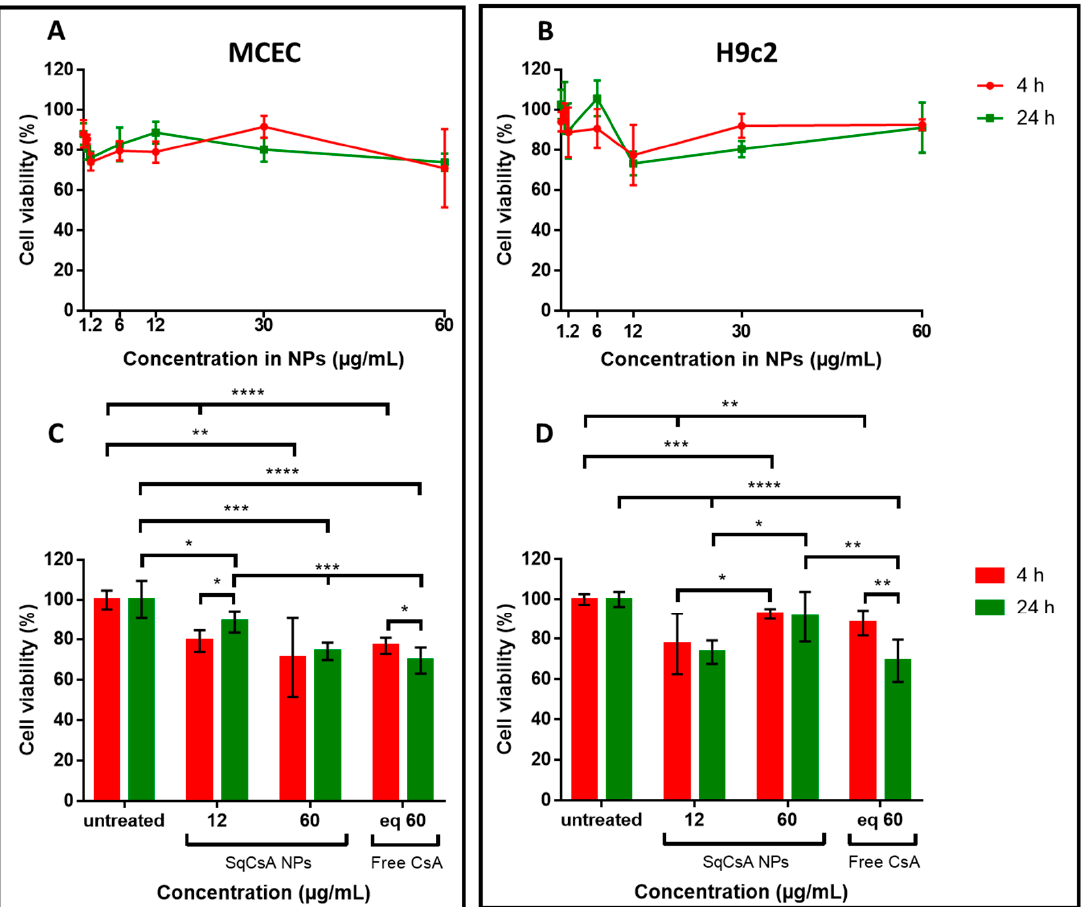
Figure 5. Cell viability assessment of Mouse Cardiac Endothelial Cells (MCEC) ( A , C ) and H9c2 ( B , D ) cell lines treated with SqCsA NPs. Cell viability is expressed as a percentage relative to the viability of untreated cells. Use of an equivalent (eq) concentration in free CsA ( C , D ). * p ≤ 0.05, ** p ≤ 0.01, *** p ≤ 0.001, **** p ≤ 0.0001.